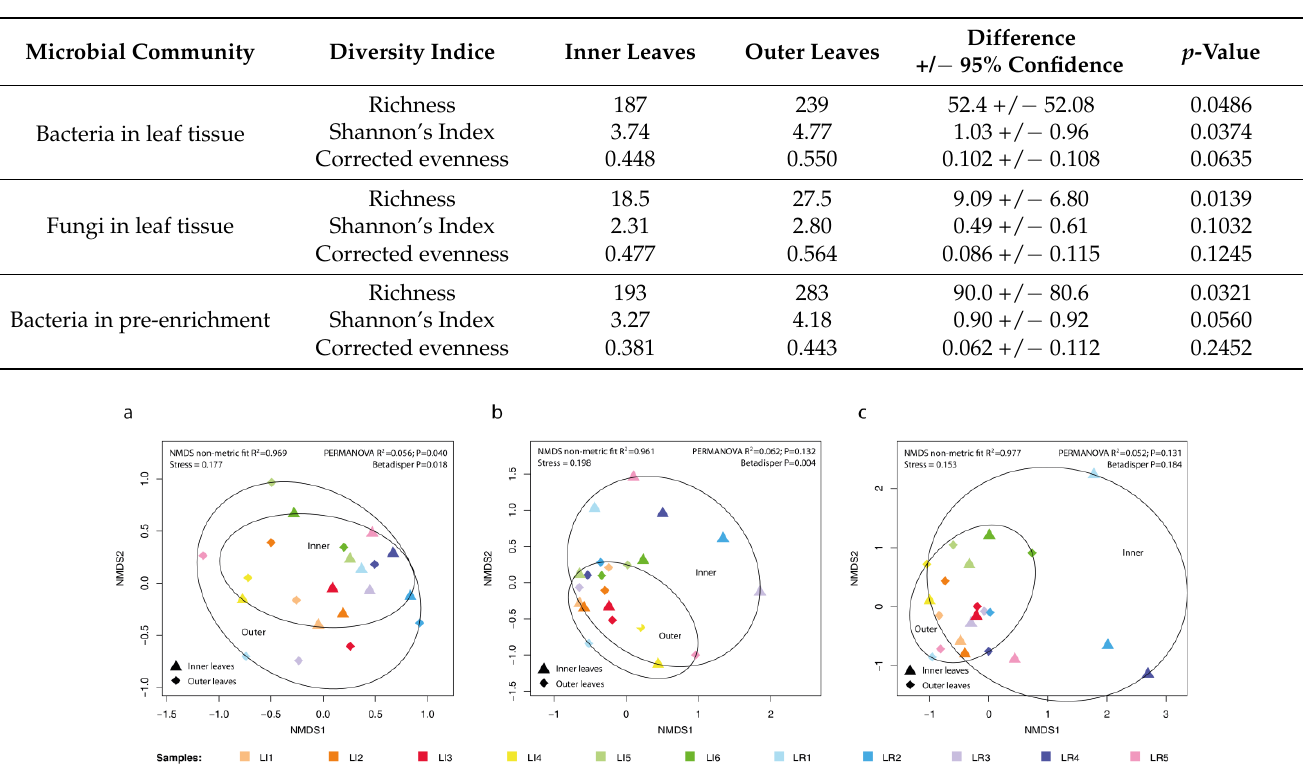
Table 3. Alpha diversity indices of microbial communities in samples of inner and outer lettuce leaves as compared by paired t-test.